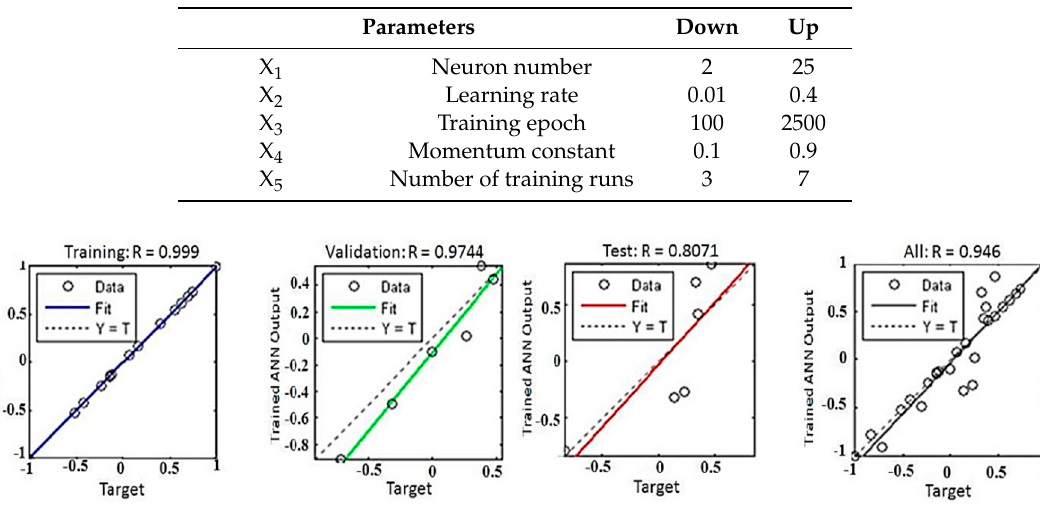
Figure 11. Training result of the proposed network.